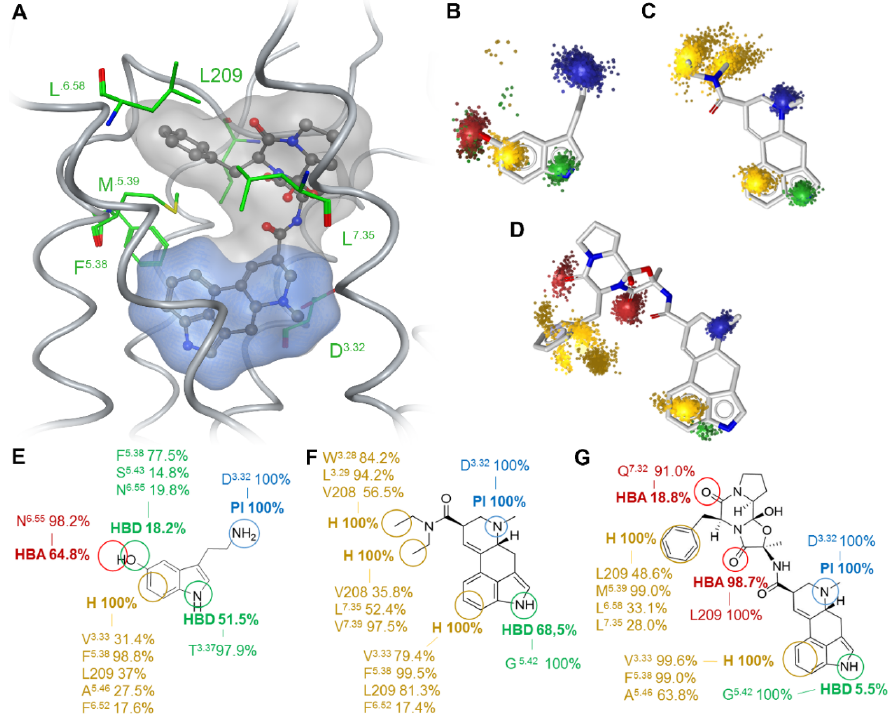
Figure 2. Extended binding modes of biased 5-HT 2B R agonists. Close-up view of the ligand binding site of 5-HT 2B R in complex with ergotamine indicating the most important residues in green ( A ). The blue surface represents the common core structure of all studied ligands, while the grey surface indicates the extended molecular structure. Dynamic pharmacophores of 5-HT ( B , E ), LSD ( C , F ), and ergotamine ( D , G ) indicate common interactions for 5-HT 2B R agonists and additional interactions likely accounting for ligand-specific effects. The percentages in panel E-G refer to the feature occurrence over 200 ns of MD simulation, while the three-dimensional dynamic pharmacophores ( B – D ) illustrate the spatial distribution of interaction features in the trajectory. The color code is composed of blue for positive ionizable areas ( PI ), yellow for hydrophobic contacts ( H ), green for hydrogen bond donors ( HBD ), and red for hydrogen bond acceptors ( HBA ).